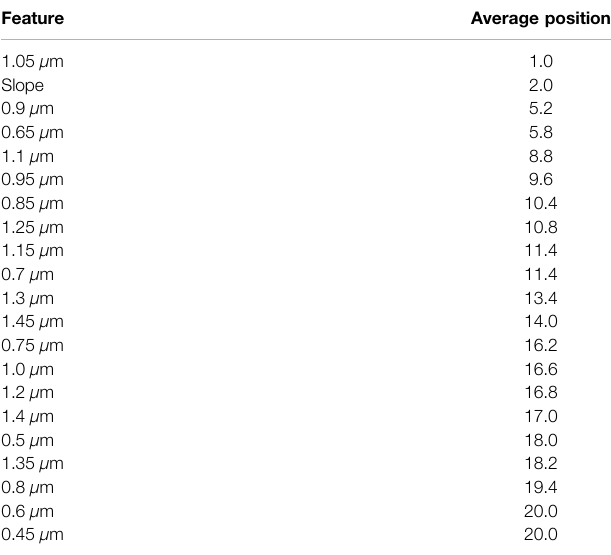
TABLE 10 | Average rank per feature for the classi fi cation of taxonomic types during sequential feature selection with balanced accuracy on spectral